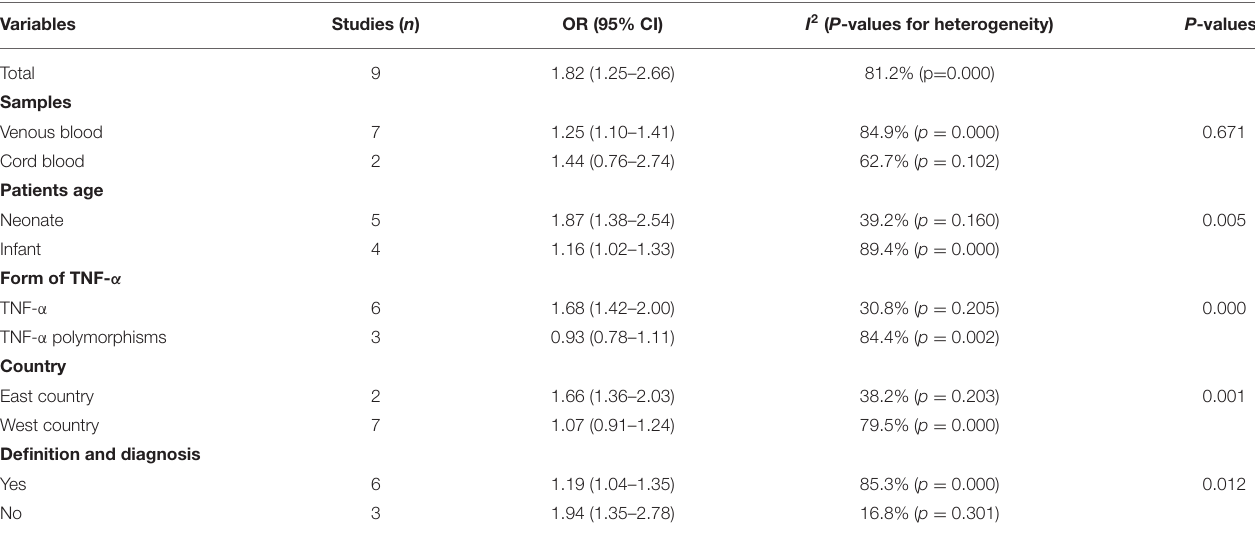
TABLE 2 | Pooled results of the association between blood TNF- α levels and